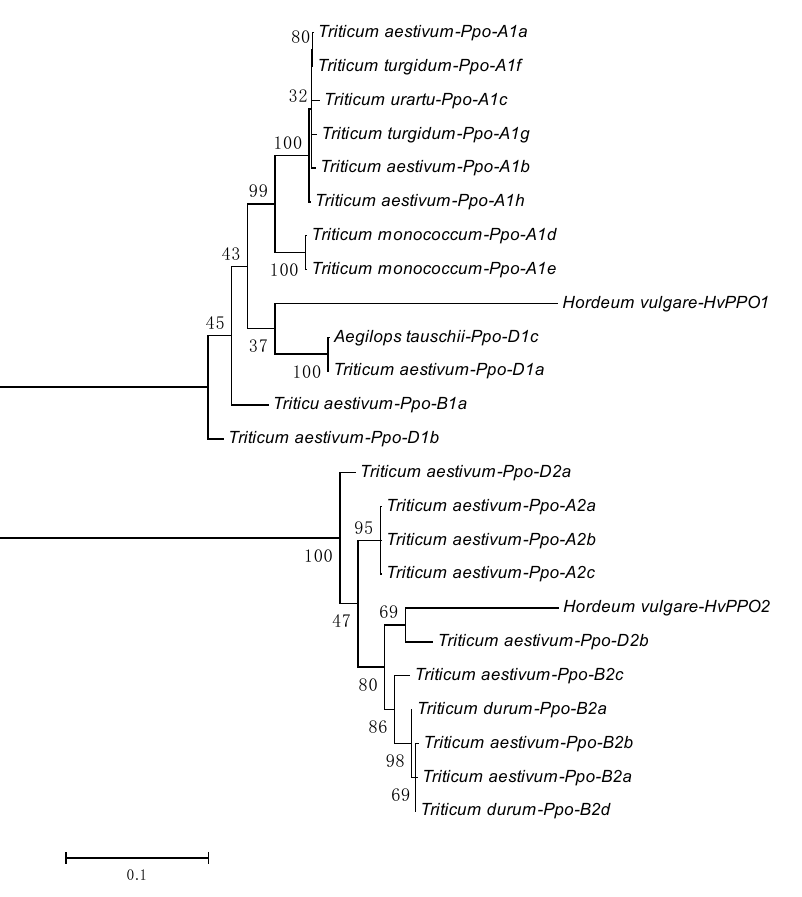
Figure 3. Evolutionary relationships between wheat and barley PPOs inferred by using the Maximum Likelihood method. Evolutionary analyses were conducted in MEGA7. Numbers below branches indicate 1000 bootstrap support values.